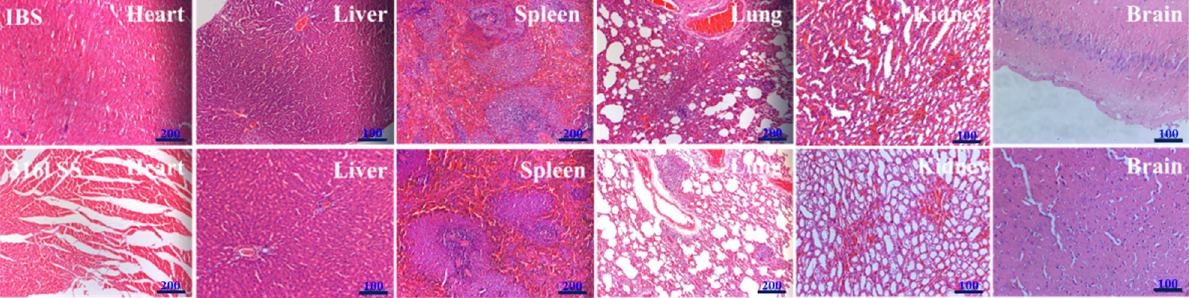
Figure 5: Histopathologic observations on organ tissues 2 years after implantation of the IBS and 316L SS ( scar bar is 100 or 200 µm )